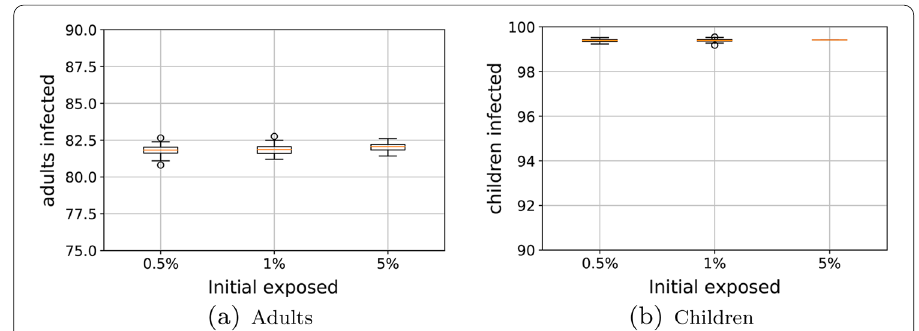
Fig. 9 Role of the initial condition. We show the cumulative number of infections (over 100 independent runs) among ( a ) adults and ( b ) children, for three different initial conditions. Our findings suggest no statistically significant difference between the outcomes of the simulations. All simulations are performed in the absence of vaccination V = 0 for Scenario I (original strain). The parameters used in the simulations are listed in Table 2, q a = 0.25 , and q c = 0.12